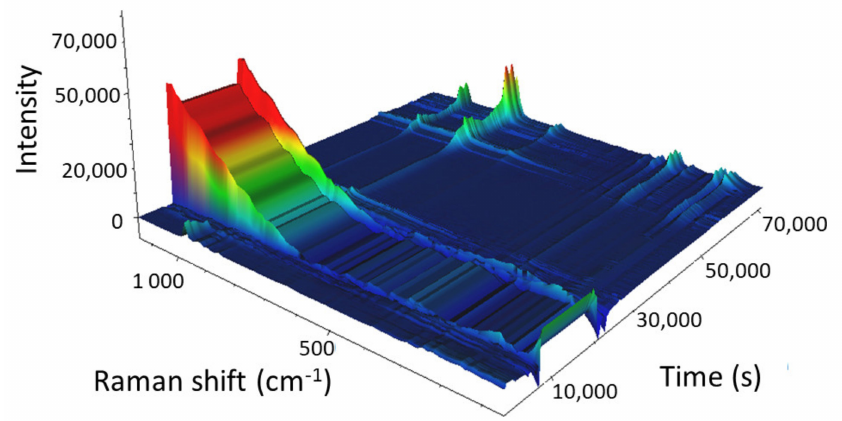
Figure 14. 3D view of the calcination of the Mo-supported beta zeolite catalyst with a Mo content of 21 wt%. Heating: start temperature 25 ◦ C; temperature gradient 1 ◦ C / min; end temperature 500 ◦ C (in 28,738 s). Isotherm for 4 h (43,072 s). Cooling: start temperature 500 ◦ C; temperature ramp 1 ◦ C / min; end temperature 50 ◦ C (70,383